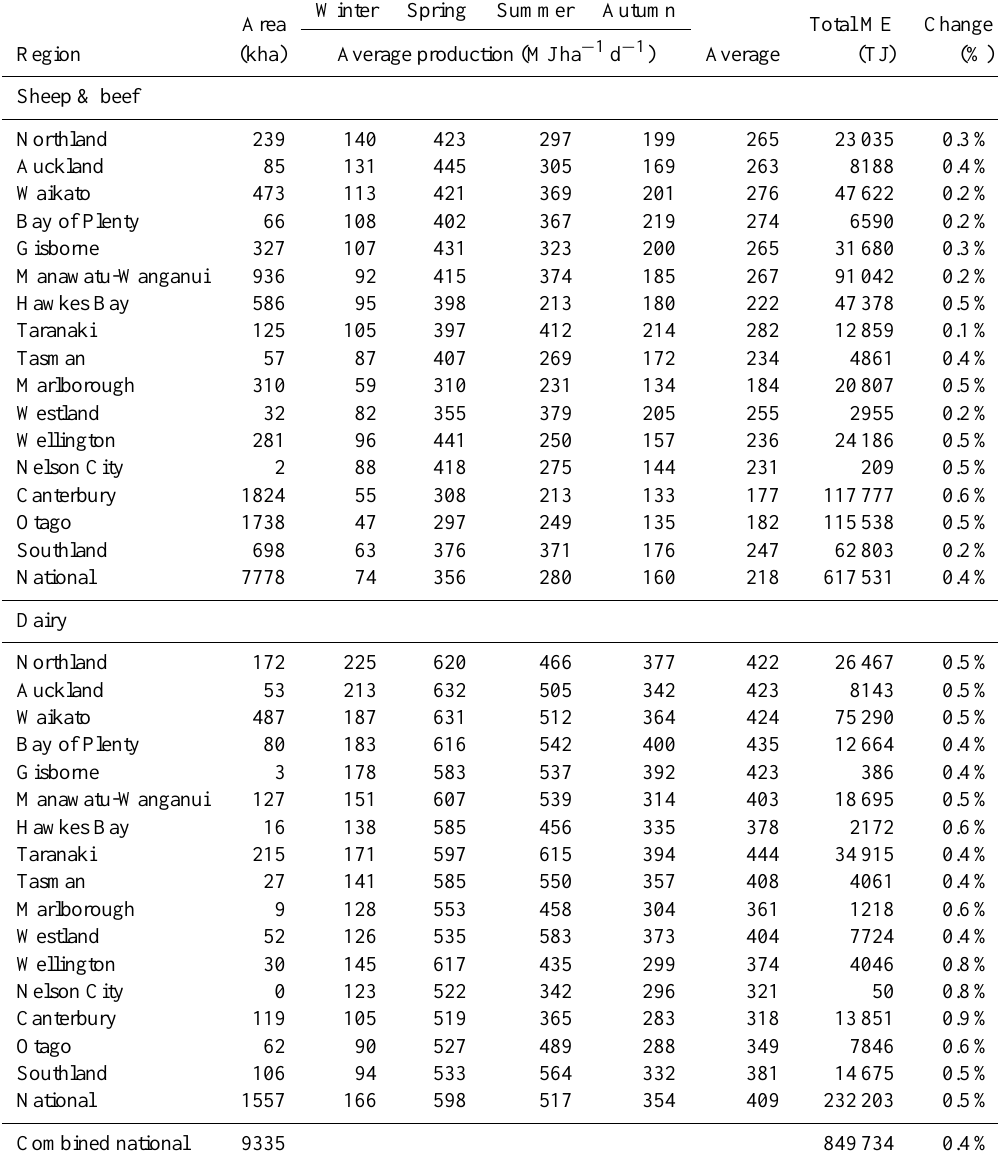
Table B3. Elevated CO 2